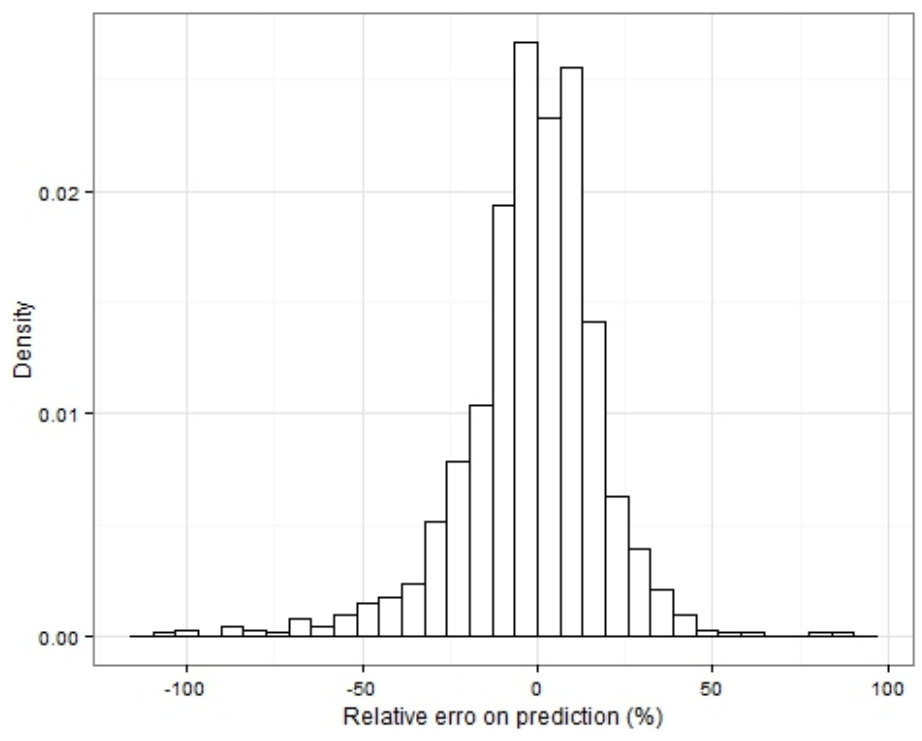
Figure 10. Distribution of the relative errors on the micro-trip energy consumption predictions using the micro